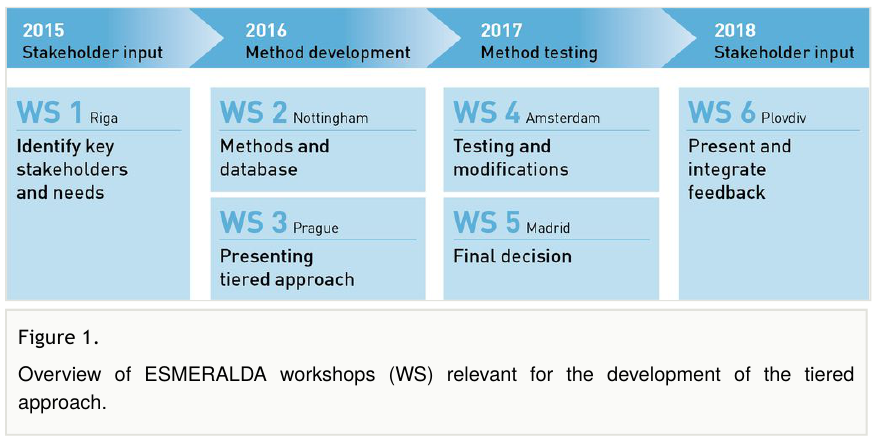
Figure 1. Overview of ESMERALDA workshops (WS) relevant for the development of the tiered